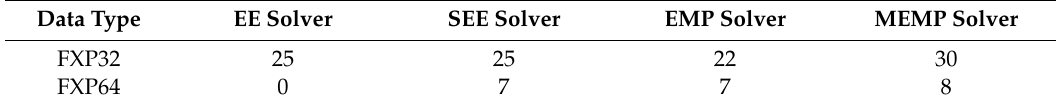
Table 4. Spiking beginning time errors between FXP and DBL solvers, ms.